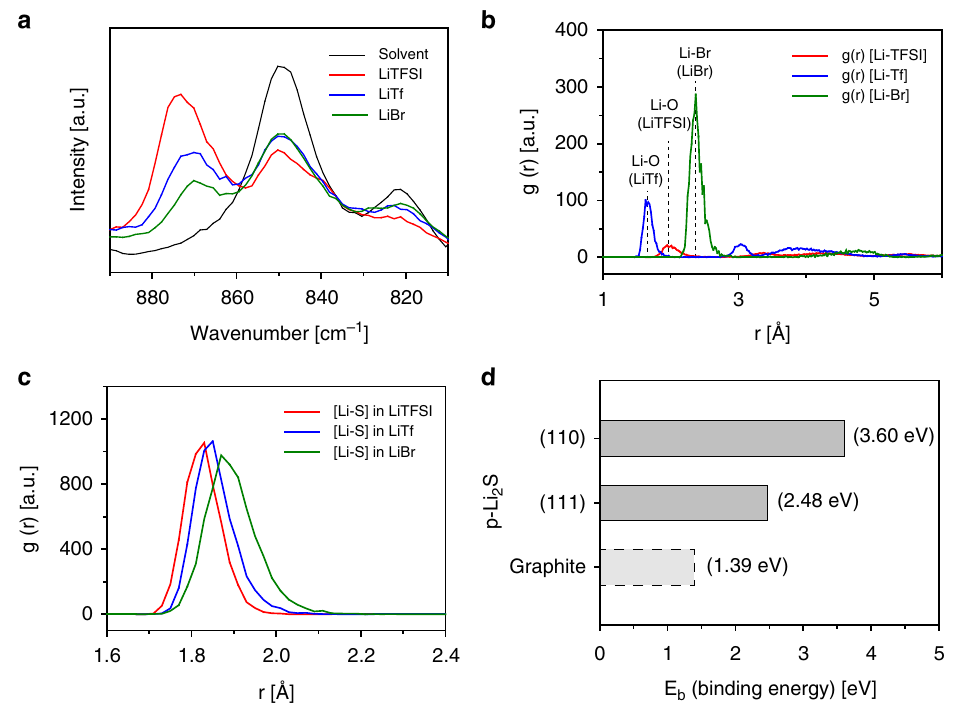
Fig. 6 The effect of electrolyte anions on lithium sul fi de solubility. a Raman spectra of 1 M LiX, X = bistri fl imide (TFSI − ), tri fl ate (Tf − ), or bromide (Br − ), supporting salts in 1,3-dioxolane (DOL):1,2-dimethoxyethane (DME) (1:1) solutions with respect to the pure solvent mixture (black). b Radial distribution functions (how density ( g ( r )) varies as a function of radial distance ( r )) of X − anions from lithium ion (Li + ) under the 1 M LiX in DOL:DME solutions. c Radial distribution functions of lithium cation – sul fi de anion (Li + – S 2 − ) in different salt environments. d Summary of the binding energy of newly generated Li 2 S on different surfaces (graphitic carbon surface vs. Li 2 S precipitates (p-Li 2 S)) based on the fi rst-principle